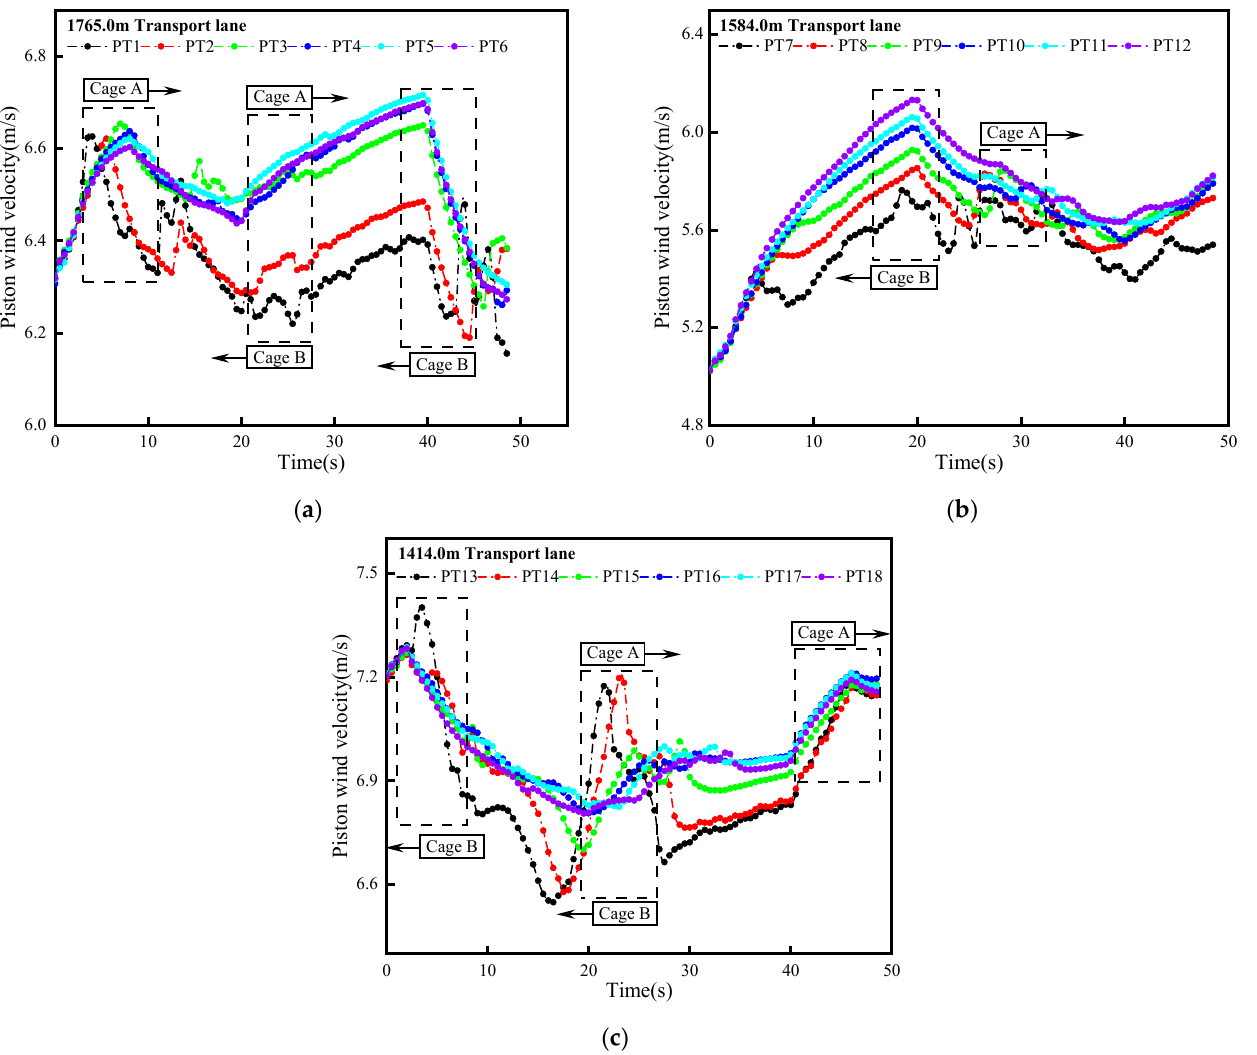
Figure 9. The time-varying curve of piston wind speed at each measuring point in different transport lane s: ( a ) 1765.0 m transport lane, ( b ) 1584.0 m transport lane, ( c ) 1414.0 m transport lane.